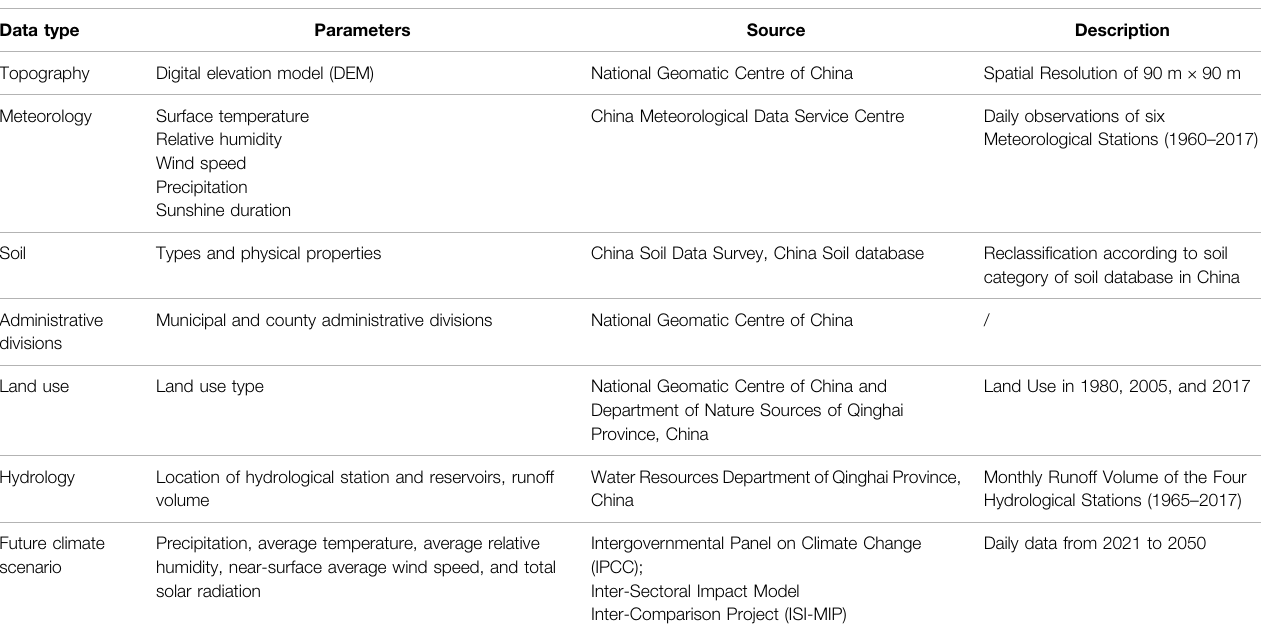
TABLE 1 | Data type, source, and